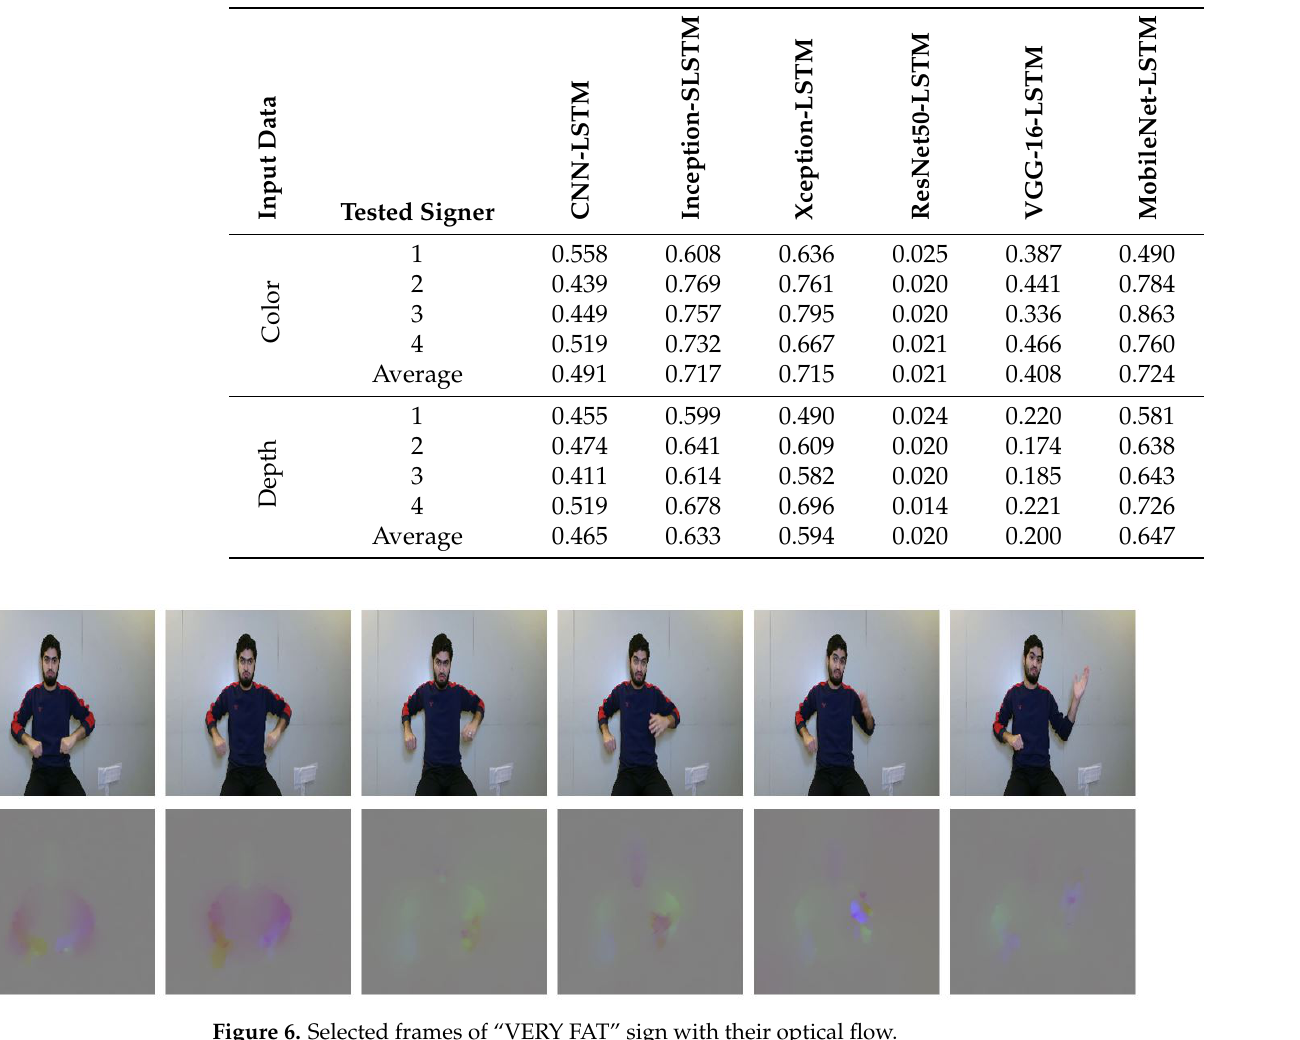
Table 4. Signer-independent recognition accuracies using the optical flow, computed either from color or from depth data.